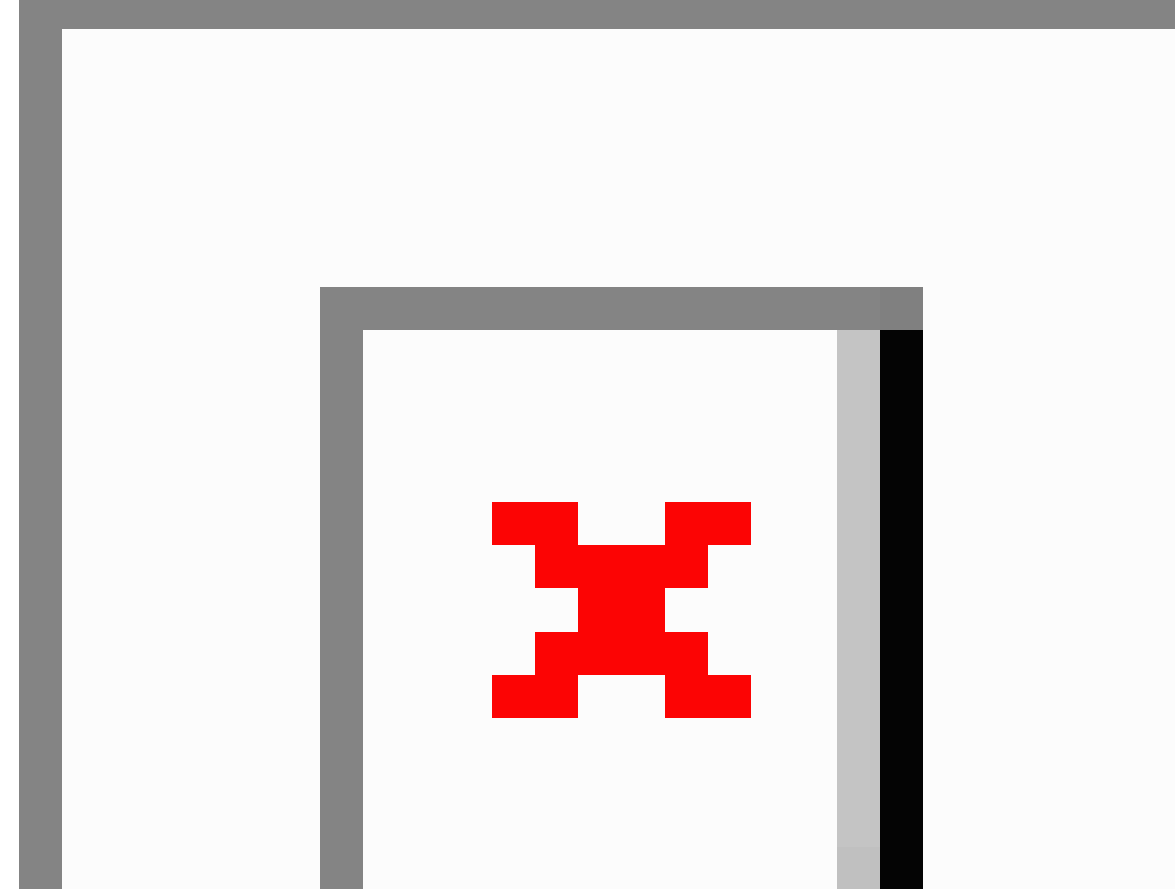
Figure 2. Distribution of HEpiTracker coverage in each hospital by calendar day (April 8 to May 30, 2020) as of June 2, 2020. ICO: Institut Català